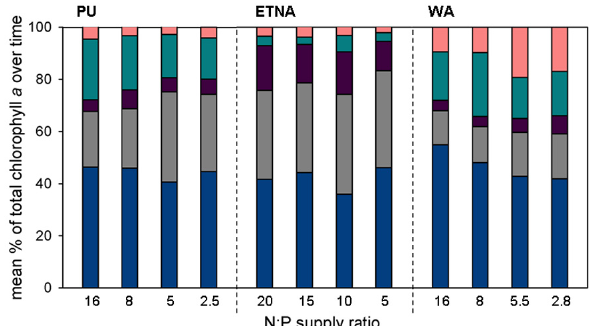
Fig. 5. Mean composition of the phytoplankton community for each N : P supply treatment over the entire duration of the respec- tive experiment based on the contribution of each phytoplankton group to total chlorophyll a . Five taxonomic groups of microal- gae are defined: diatoms (blue), flagellates (grey; including chryso- phytes, haptophytes, dinoflagellates and crytophytes), chlorophytes (dark purple; including chlorophytes and prasinophytes), N-fixing cyanobacteria (green), picocyanobacteria (pink; including Syne- chococcus ).